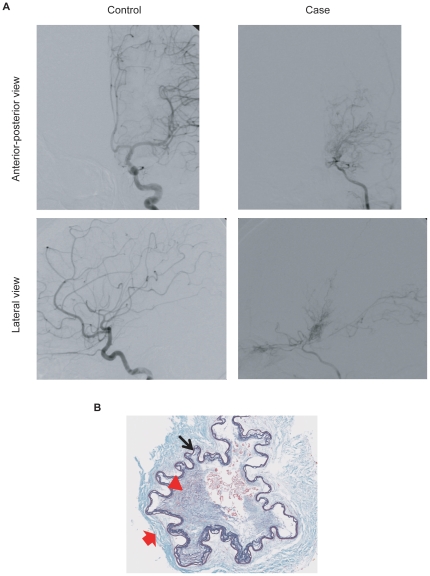
Clinical features of moyamoya disease.(A) An anterior-posterior and lateral views of left internal carotid angiography in a 9-year-old child with moyamoya disease (right) and an 8-year-old control child (left). An occlusion with moyamoya vessels can be seen around the terminal portion of the internal carotid artery and proximal portions of the anterior cerebral artery and middle cerebral artery in the affected child. (B) Intimal hyperplasia in the middle cerebral artery from an autopsy of a 69-year-old case. Intimal hyperplasia (red arrowhead), atrophic media (red arrow) and winding internal elastic lamina (black arrow) can be seen with Elastica Masson staining, ×200.